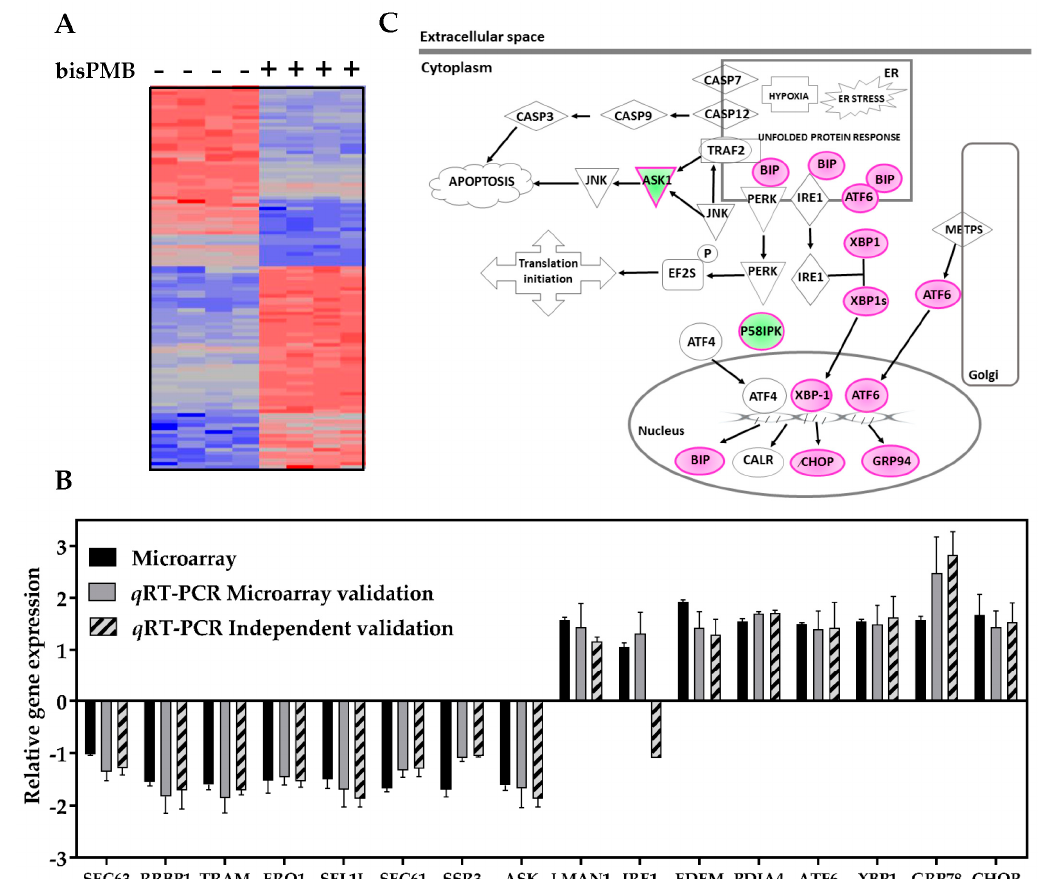
Figure 2. Transcriptional profiling of WHCO1 oesophageal cancer cells treated with bisPMB. ( A ) Microarray hierarchical clustering. The hierarchical clustering of genes from the Affymetrix Gene Chip Human Gene 2.0 ST Array consisting of four experimental replicates of control and bisPMB-treated WHCO1 cells. Each gene is represented by a column, and each sample is represented by a row. Expression changes: unchanged (grey), up-regulated (red), down-regulated (blue). ( B ) Microarray validation. The fold change of 16 DEGs obtained from the microarray (black) were validated by reanalysing the same microarray mRNA by q RT-PCR (grey); and independently by extracting new mRNA from an independent experiment and analysing by q RT-PCR (hashed). All data was normalized relative to GAPDH. ( C ) Gene network of the ER stress pathway. The DEGs from the microarray are highlighted in green (down-regulated) or red (up-regulated). The cellular compartments are labelled inside the shape demarcating them.